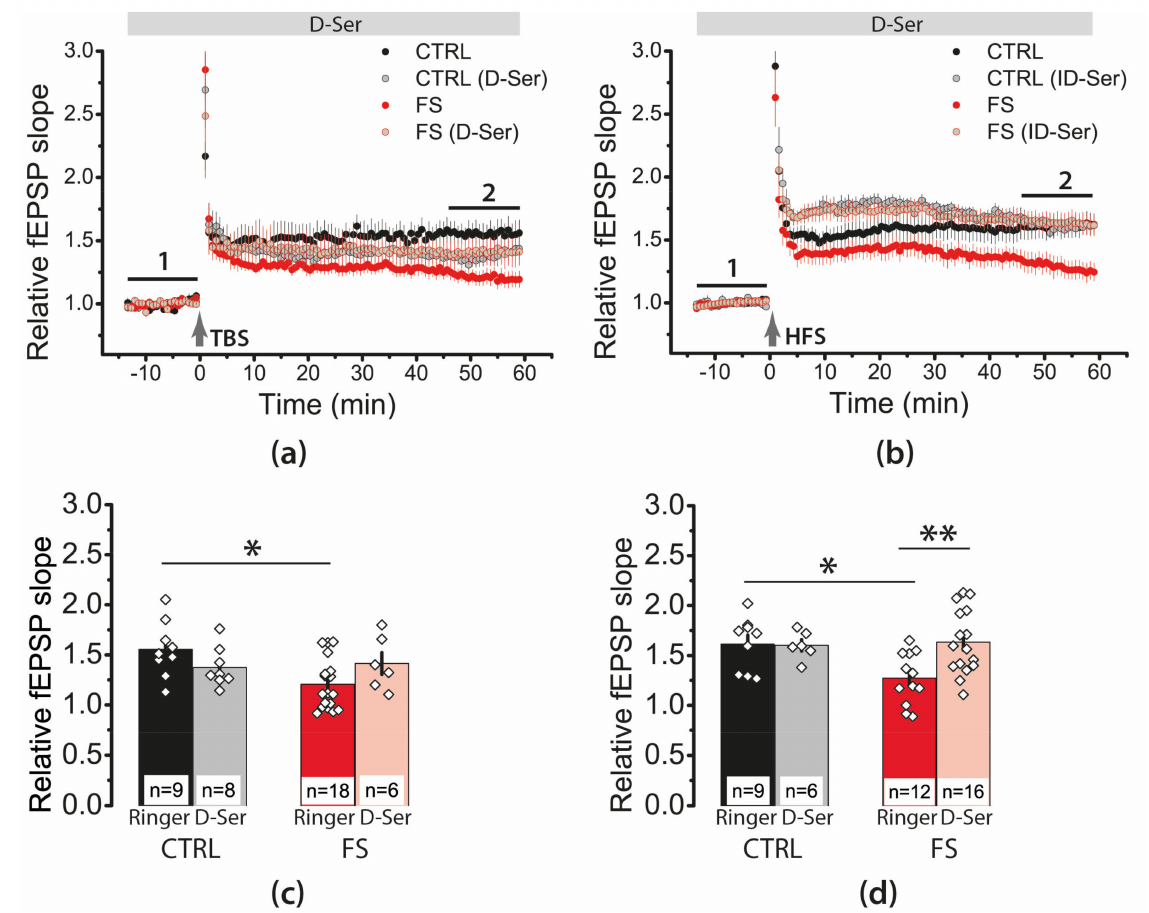
Figure 9. D-serine, a co-agonist of NMDARs, enhanced LTP in the FS but not control group. The normalized fEPSP slope in the control and FS groups in the presence of the NMDAR co-agonist D-serine (10 µ M), before and after TBS ( a ) or HFS ( b ). ( c , d ) Diagrams illustrating the magnitude of plasticity in the control and experimental groups in the presence of D-serine after TBS ( c ) or HFS ( d ). Two-way ANOVA following Tukey post hoc tests: * p < 0.05, ** p < 0.01.